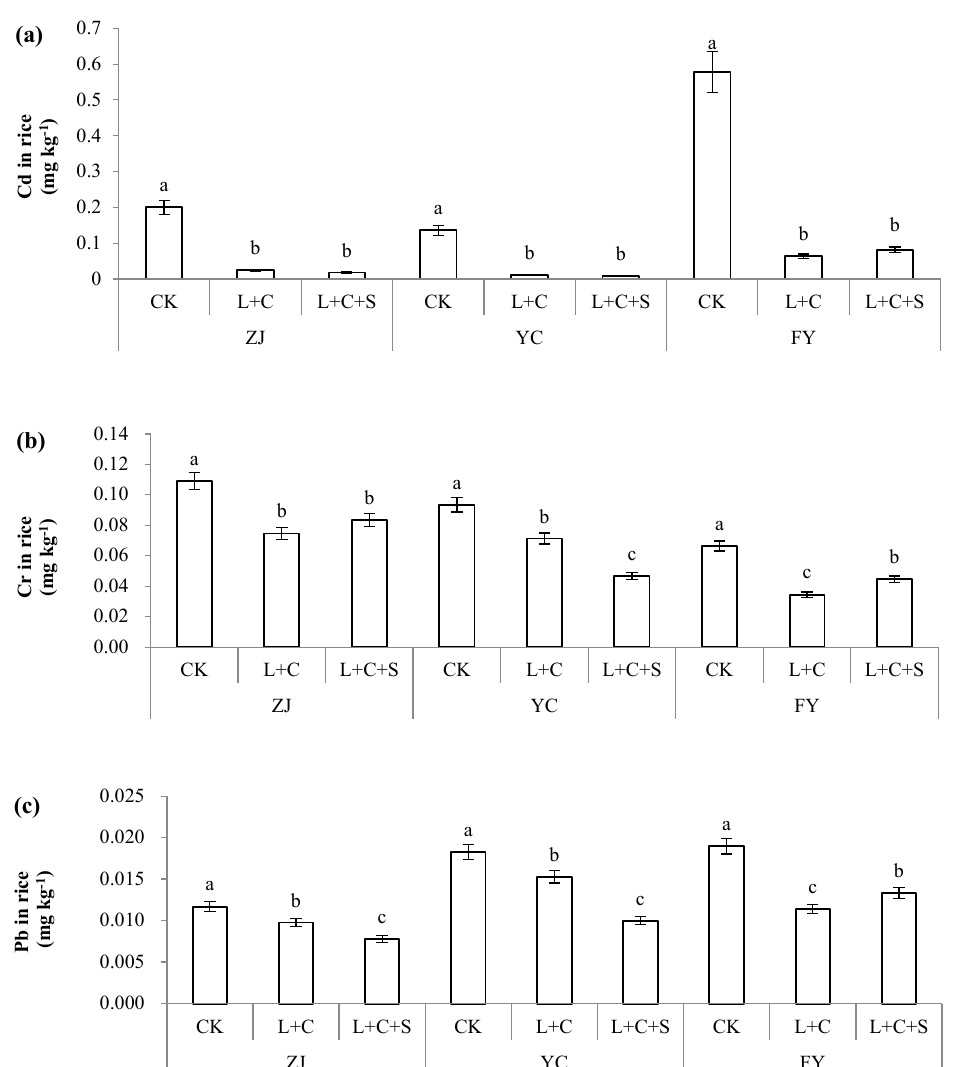
Figure 1. Cd ( a ), Cr ( b ), and Pb ( c ) in rice treated by control with no passivators (CK), 9000 kg ha − 1 of lime + biochar with a rate of 1:1 (L + C), and 9000 kg ha − 1 lime + biochar + sepiolite with a rate of 1:1 (L + C + S) in paddy soil. Values (means ± SD, n = 3) with different letters indicate significant differences between objects in the respective sites (separately for ZJ (Zhuji), YC (Yuecheng), or FY (Fuyang)).